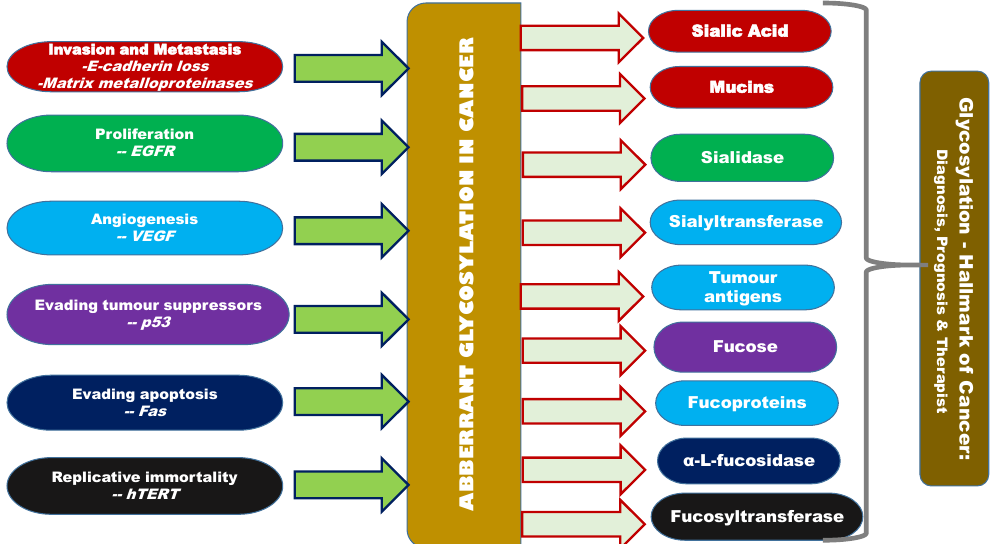
Figure 2. Overview of aberrant glycosylation and its correlation with other hallmarks of cancer, altered expression of sialic acid, siayltransferase, sialidase, sialoproteins, fucose, fucoprotein, fucosidase, fucosyltransferase, mannose and galactose inter-correlated with cancer hallmarks like invasion, metastasis, proliferation, angiogenesis, evasion of growth suppressors, apoptosis, and replicative immortality.